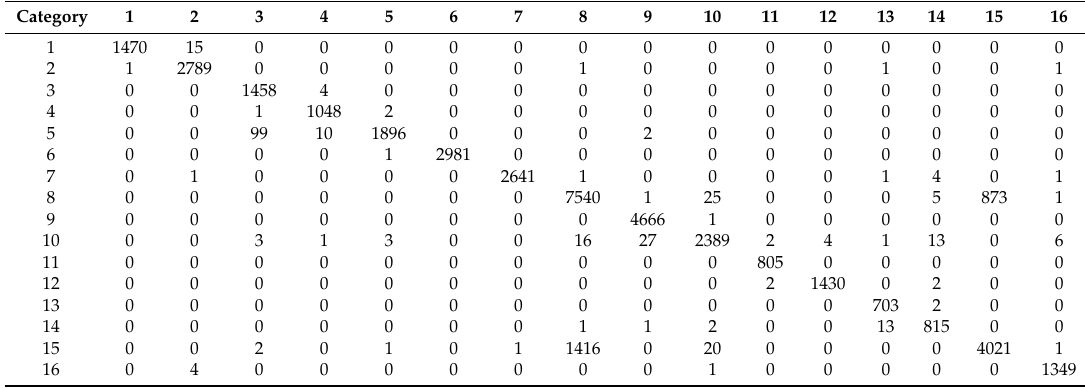
Table 11. Confusion matrix for traditional CNN classification used Salinas dataset.